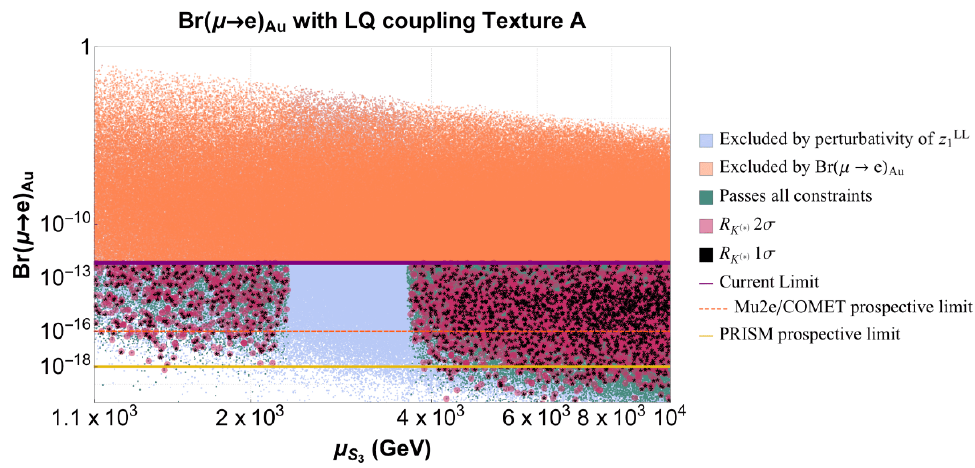
Figure 12 . Indicative plot of the allowed parameter space scans showing (cid:22) S vs. Br( (cid:22) ! e ) Au , 3 for leptoquark coupling matrix Texture A. The purple line indicates the current Br( (cid:22) ! e ) Au cut- o(cid:11) of 7 : 0 (cid:2) 10 (cid:0) 13 , and the dotted orange (yellow) line indicates the prospective cut-o(cid:11) from the Mu2e/COMET (PRISM) experiment which is of order 10 (cid:0) 16 (10 (cid:0) 18 ). The orange region of the parameter space is constrained by Br( (cid:22) ! e ) Au , the teal region is allowed; speci(cid:12)cally it passes all constraints discussed in section 3 as well as perturbativity constraints on the diquark coupling constants z LL . The light blue region is excluded by the perturbativity constraints on diquark 1 ij couplings. The black (pink) region solves the R anomalies to 1(2) (cid:27) . K ( (cid:3) )